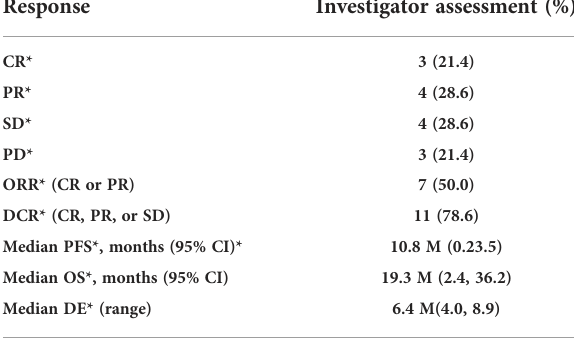
TABLE 2 Response to treatment (n/%).